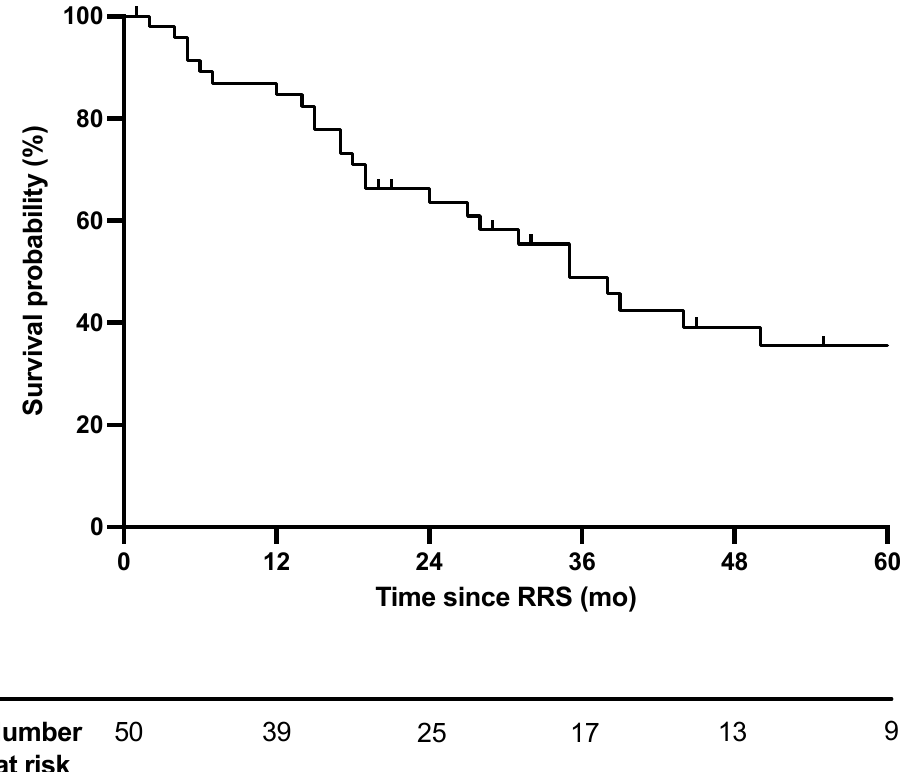
Figure 2. Overall survival after robotic radiosurgery. Overall survival (OS) was calculated with Kaplan–Meier method and is depicted in months (mo). OS is calculated from the time of robotic radiosurgery (RRS) until death (event) or loss to follow-up (censored). RRS: robotic radiosurgery, mo: months.